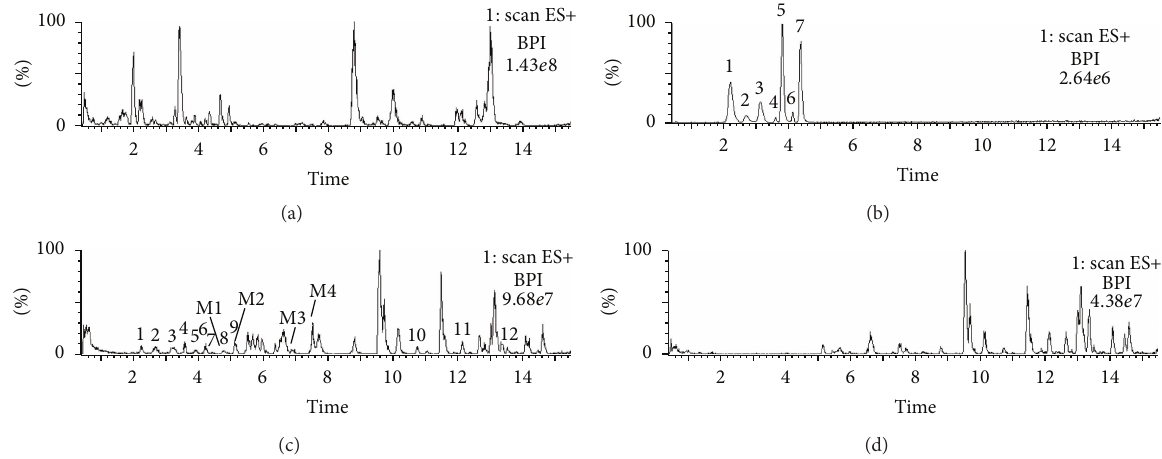
Figure 1: Total ion chromatogram of (a) WJSH capsule extract, (b) mixture of standards, (c) WJSH capsule serum sample, and (d) blank rat serum in positive mode. Peaks: 1, syringin; 2, protocatechuic acid; 3, liguiritin; 4, ferulic acid; 5, isofraxidin; 6, chlorogenic acid; 7, liqustilide; M1, M2, M3, and M4, stand for metabolites 1, 2, 3 and 4, respectively.